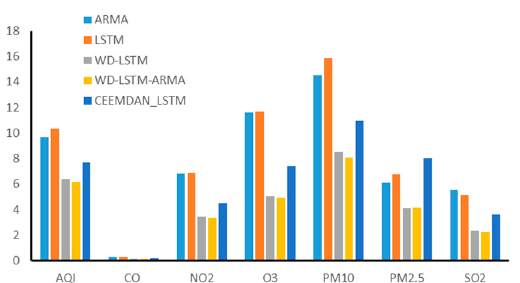
Figure 8. The MAE histogram of prediction results for each model.